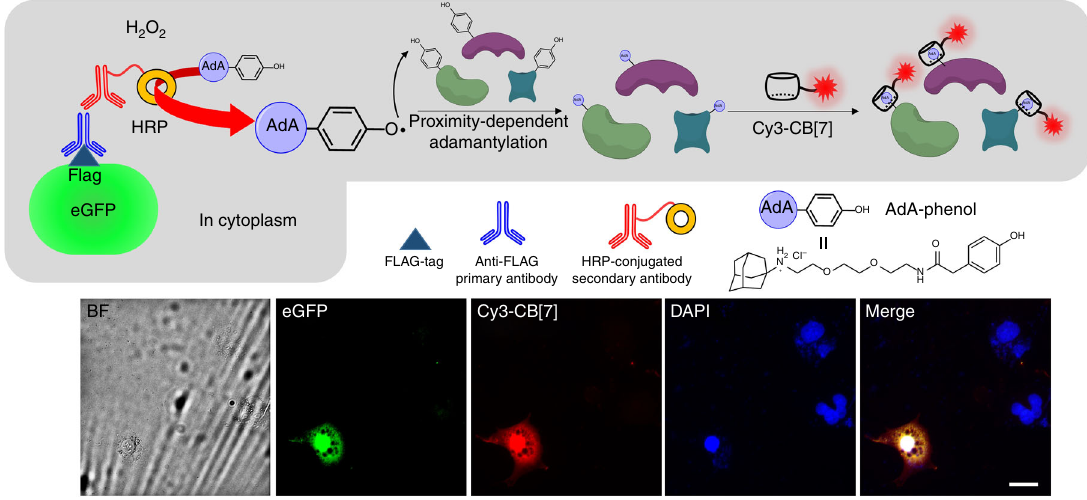
Fig. 4 Visualization of intracellular proteins. Schematic illustration for adamantylation on cytoplasmic proteins using immunospeci fi cally introduced HRP on eGFP and fl uorescence microscopy images of the fi xed COS7 cells which have FLAG-eGFP expressed in cytoplasm. Scale bar = 20 μ m